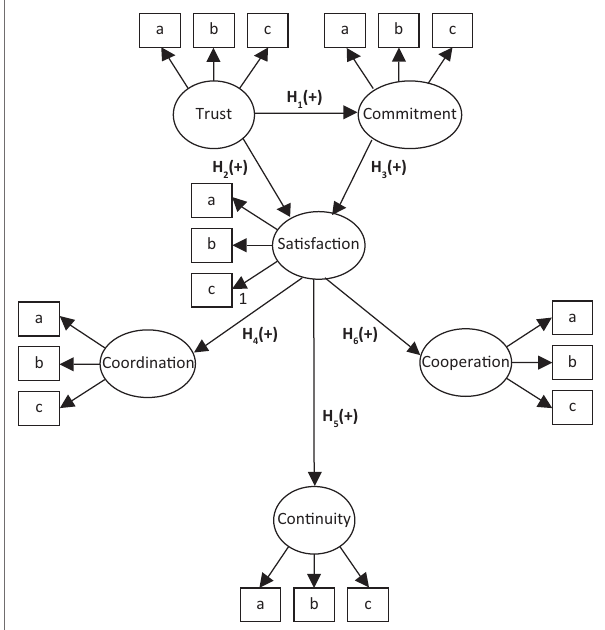
FIGURE 2: Six-construct structural model. TABLE 6: Goodness-of-fit measures of the structural model. Study